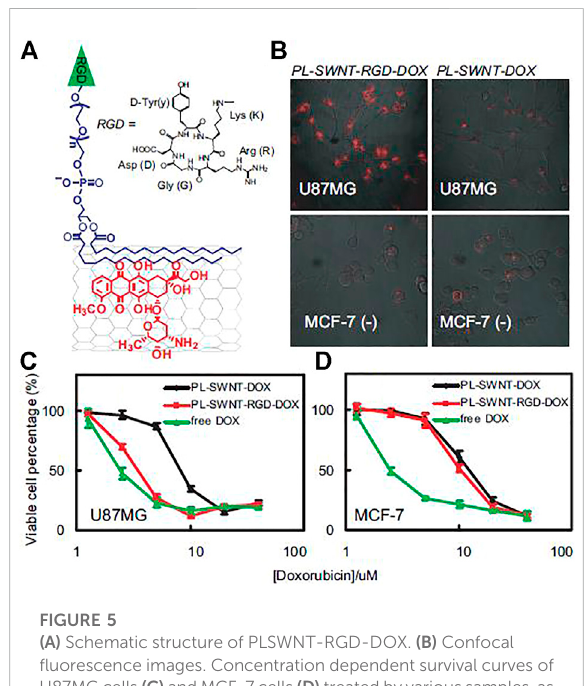
FIGURE 5 (A) Schematic structure of PLSWNT-RGD-DOX. (B) Confocal fl uorescence images. Concentration dependent survival curves